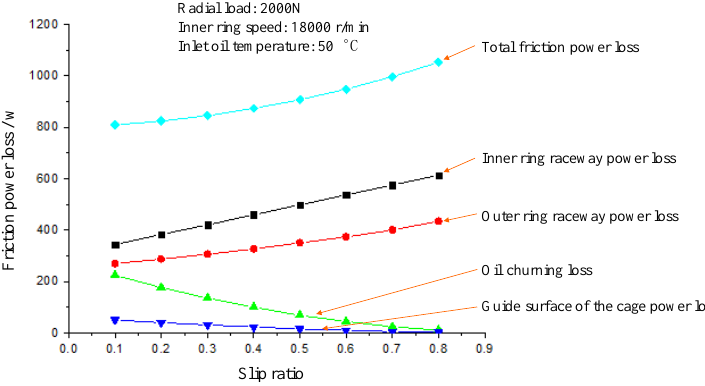
Figure 4. Effect of the slip ratio on the friction power loss of the bearing.